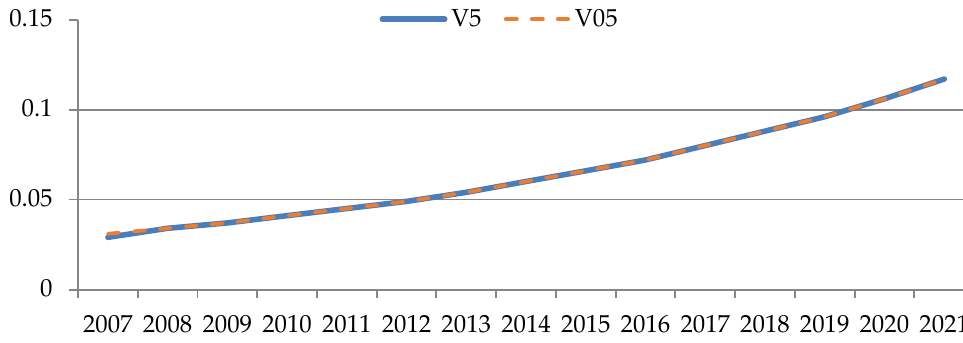
Figure 11. Graphs for tracking the target revenue indicator for industry No. 5 (author’s results).